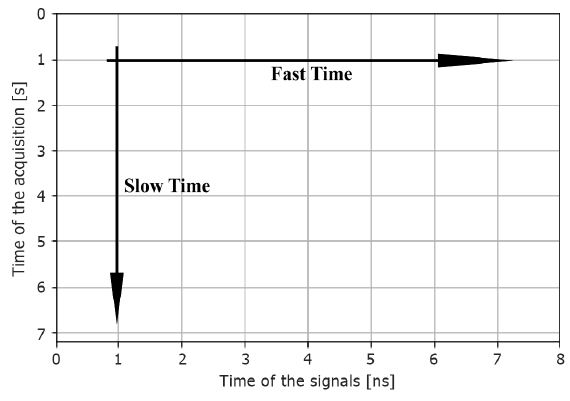
Figure 4. Slow Time and Fast